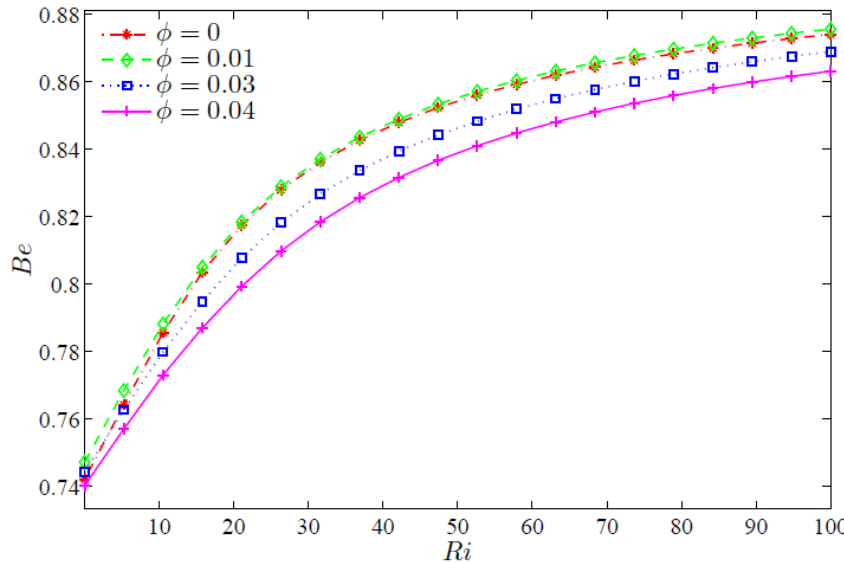
Figure 10. Be vs. Ri for various (cid:2038) at (cid:1840) = 3 .